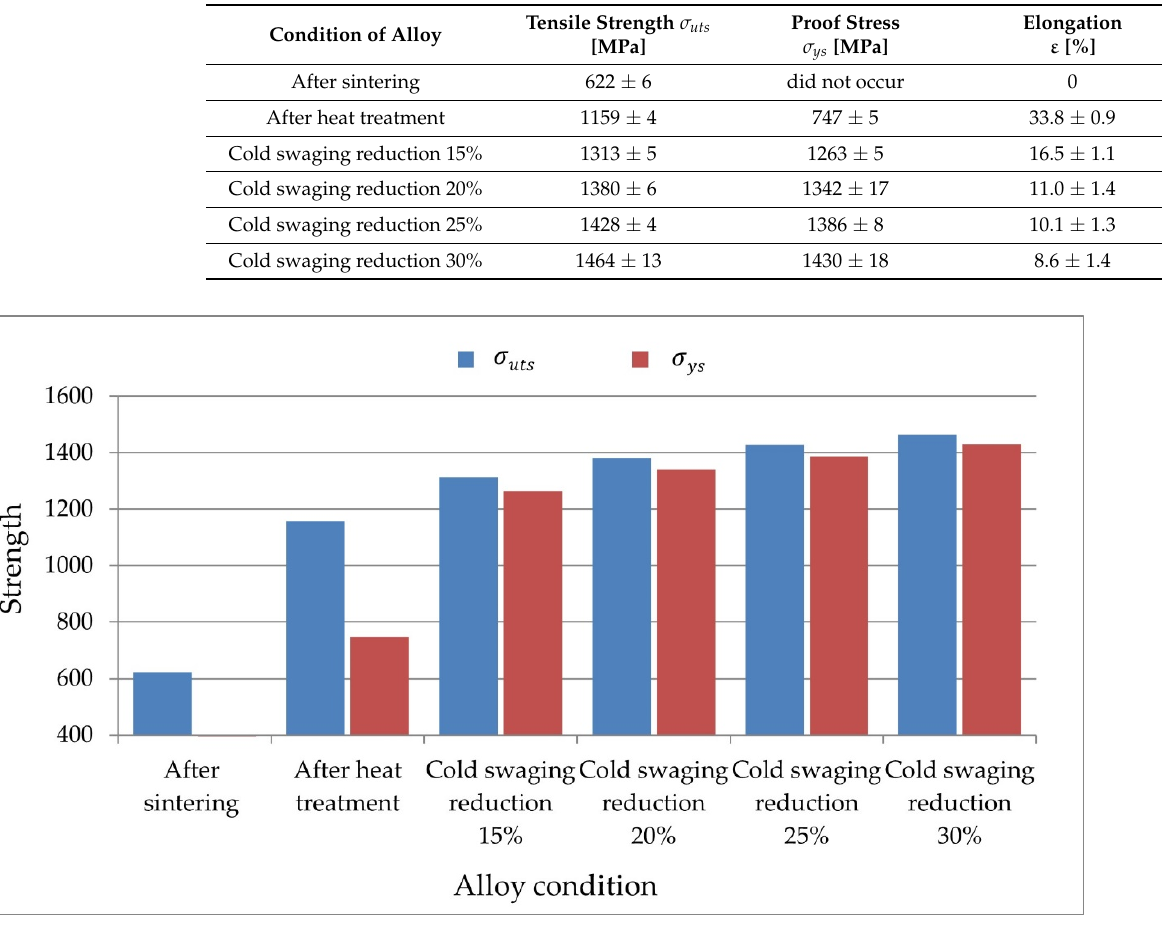
Figure 7. The results of tests of tensile strength σ uts and proof stress σ ys